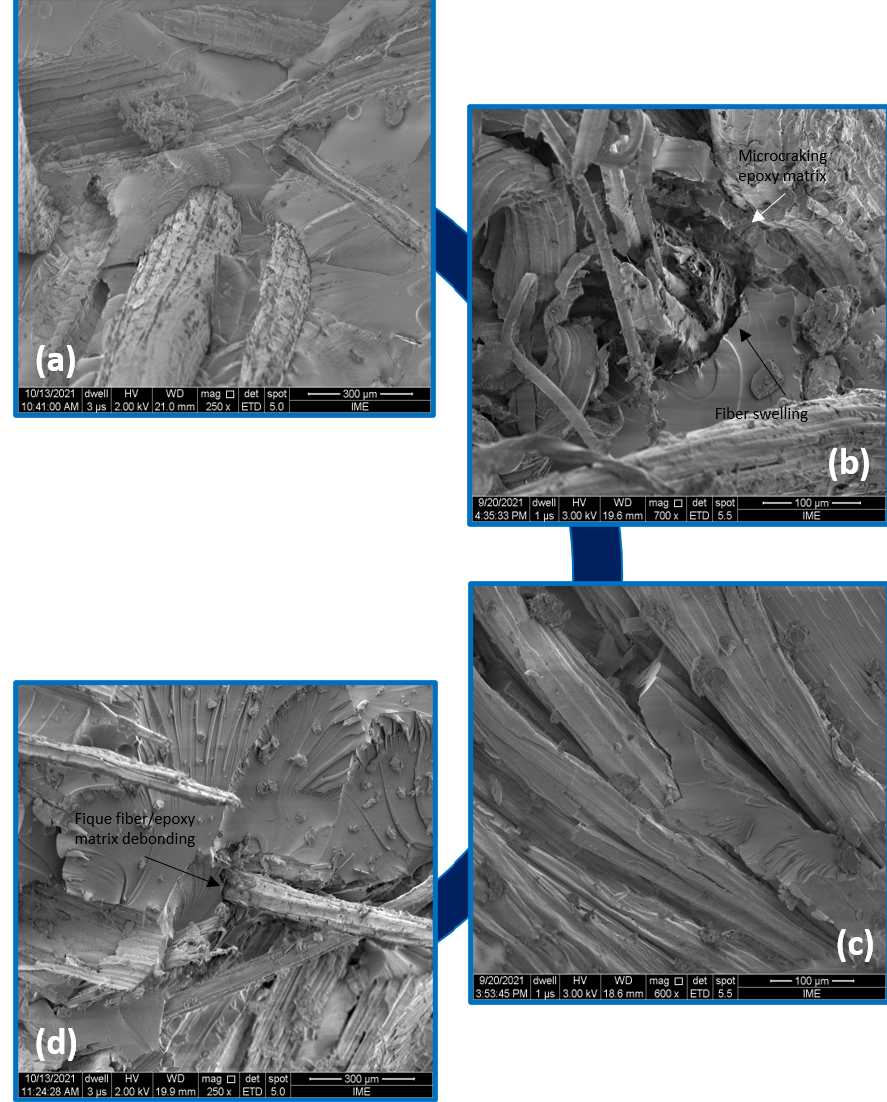
Figure 7. SEM microscopy appearance of the composite: control group ( a ) and water immersion aged after 240 h ( b ), 720 h ( c ) and 1440 h ( d